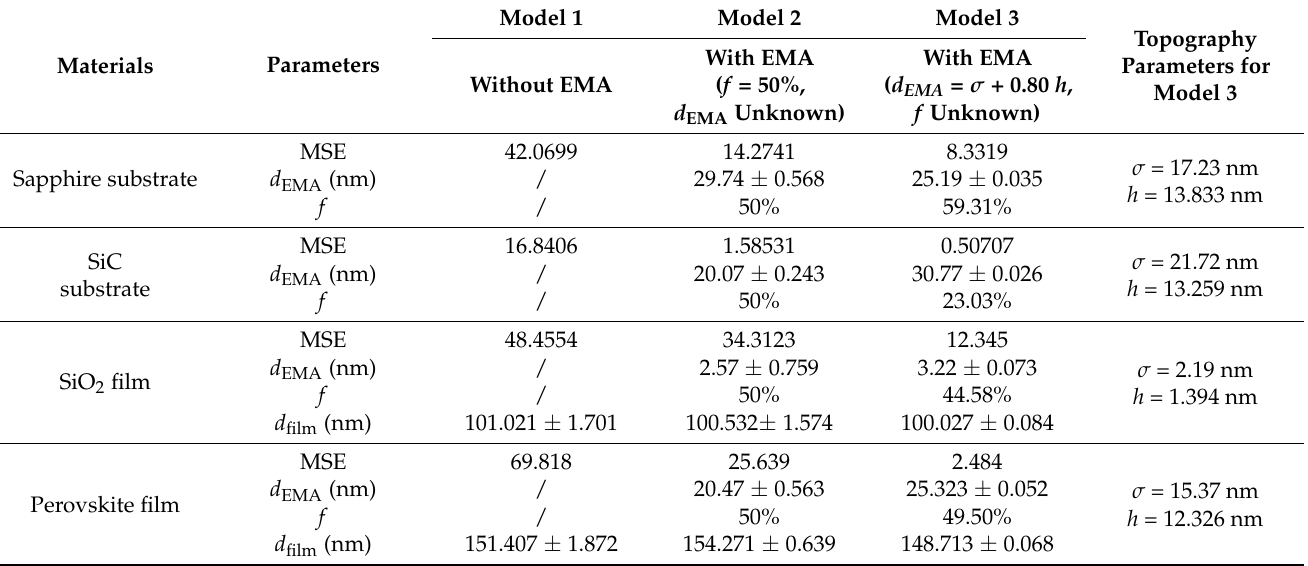
Table 4. Experimental results of the samples from four materials with three